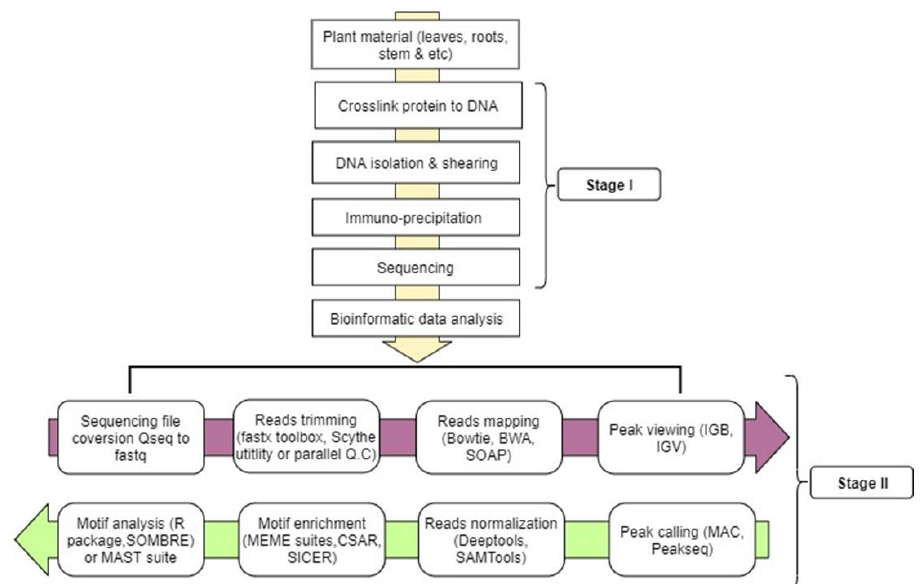
Figure 2. Basic steps involved in ChIP-seq: stage I starts from crosslinking to sequencing and stage II involves steps for gene mining. Sequenced file Qseq are converted to fastq format using fastx tools, reads undergo trimming and filtering using Scythe utility or parallel Q.C, then reads alignment using Bowtie or Burrow Wheelers alignment (BWA), matched reads viewing is aided by integrative genome browser (IGB). Peaks are called using any available software like MAC / Peakseq, reads are normalized by removing duplicate reads and searching for tag densities in a window of reads per kilobase per million reads (RPKM) around the reference peak, mostly 1 kb upstream of transcription start site (TSS) to transcription end site (TES), with SAMTools, motif search using MEME suites, and finally predicts gene through MAST suite or R statistic package SOMBRE with the aid of GO and transcription factor databases like